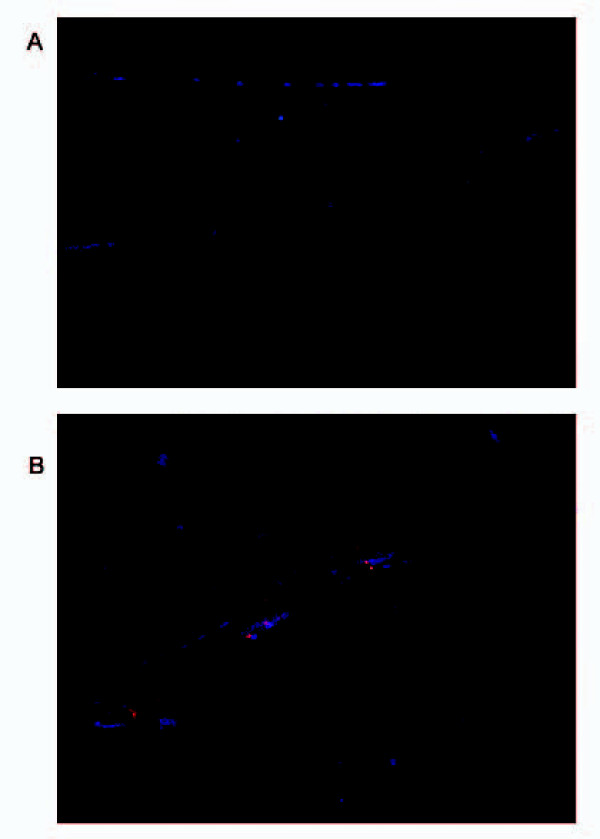
Detection of dystrophin with exon specific antibodies. Cultures containing dystrophic myoblasts were seeded in 8 well chambers and were targeted with a 72 hour recovery time after the addition of the either the nonspecific ODN (A) or mdx47NT (B). These cells were then allowed to differentiate for 96 hours at which point they were fixed and incubated with antibody specific for a rabbit polyclonal antibody that recognizes dystrophin and a secondary Alexa fluor labeled antibody (red). The cell nuclei were stained with DAPI, which is shown in blue.